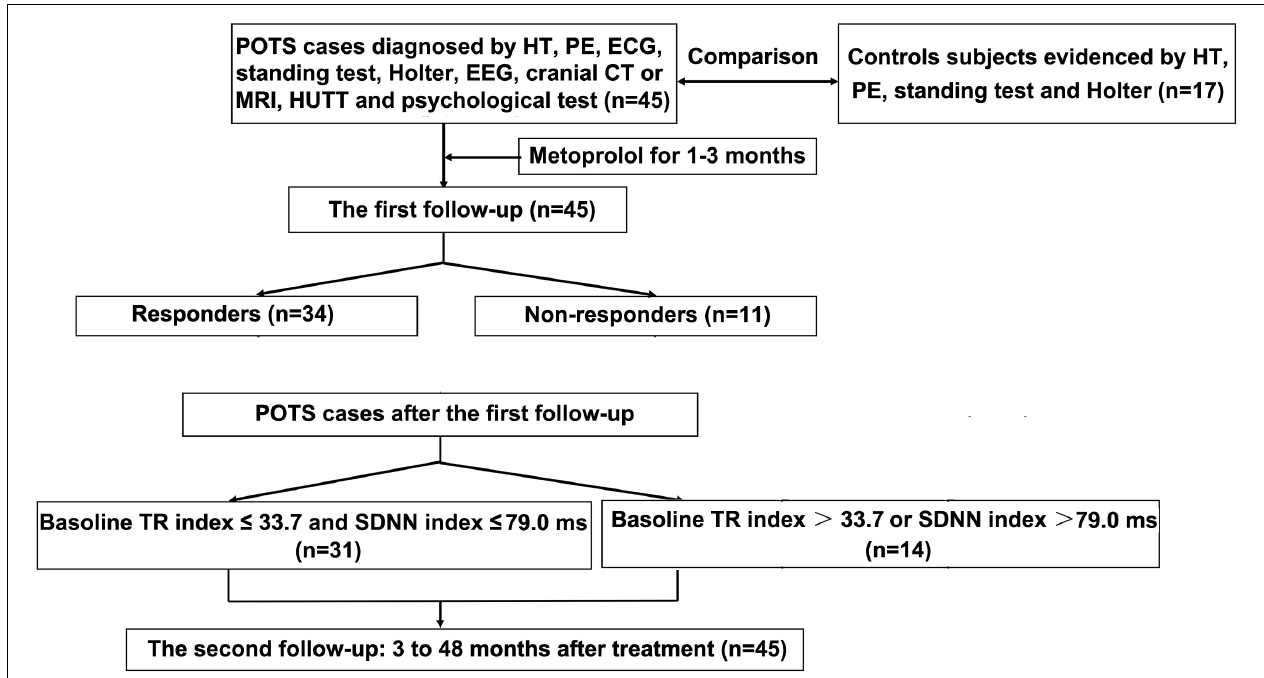
FIGURE 1 | Flowchart of enrollment of study population. POTS, postural tachycardia syndrome; HT, history taking; PE, physical examination; ECG, electrocardiography; EEG, electroencephalography; CT, computed tomography; MRI, magnetic resonance imaging; HUTT, head-up tilt test; TR index, triangular index.